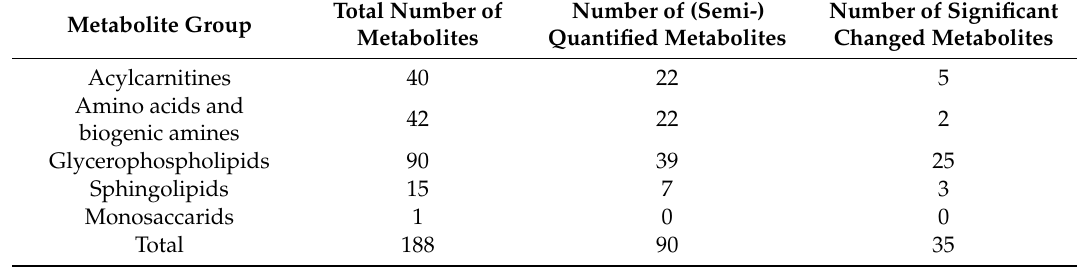
Table 2. Number of metabolites investigated in human hair.